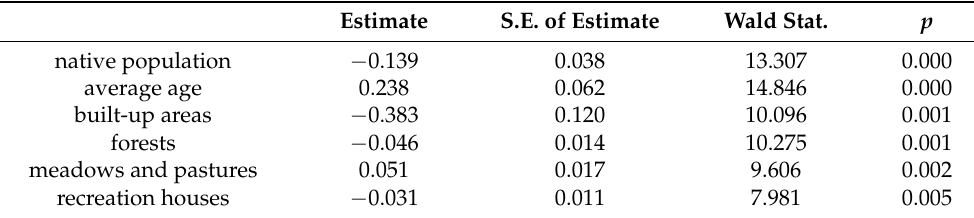
Table 2. Testing of regression estimates for the high-high concentration of post-agricultural brown- fields detected in the year